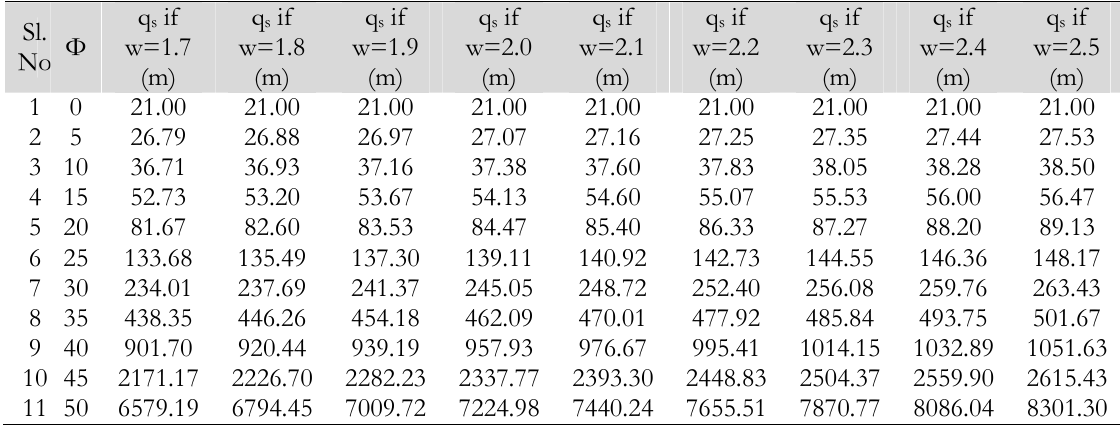
Table 4: Safe bearing capacity of soil when width of foundation (w) is varied, cohesion is zero, depth of foundation is 1.5 m and soil density (  ) is 14 kN/m 3